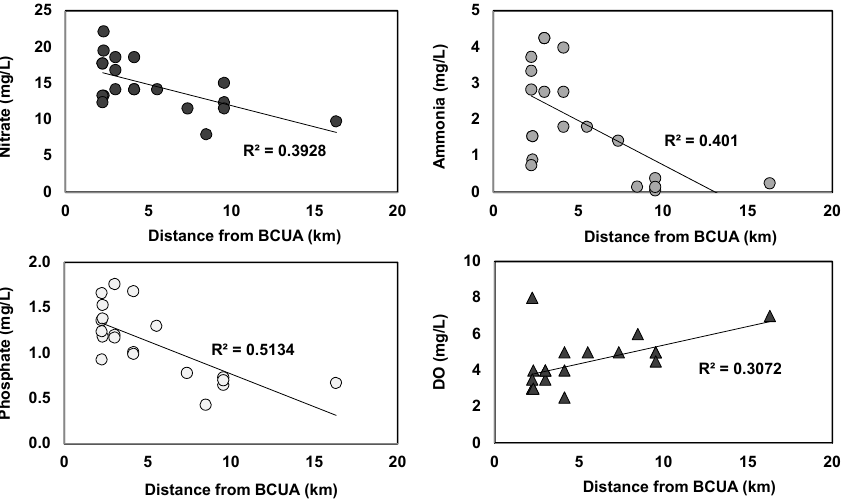
Figure 3. Correlation between the distance from the Bergen County Utilities Authority (BCUA)’s wastewater treatment plant and dissolved nutrients and oxygen in water samples ( n = 20; Tables 1 and 3) collected from the Hackensack River in summer 2016.